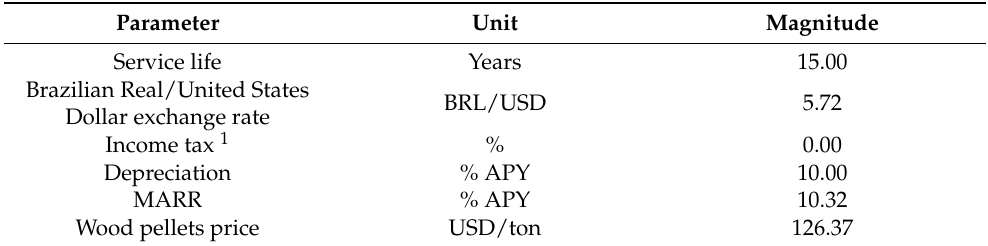
Table 10. Complementary data for the economic feasibility assessment of the gas microturbine and downdraft gasifier-based generation system using oxygen-enriched air as a gasification agent.